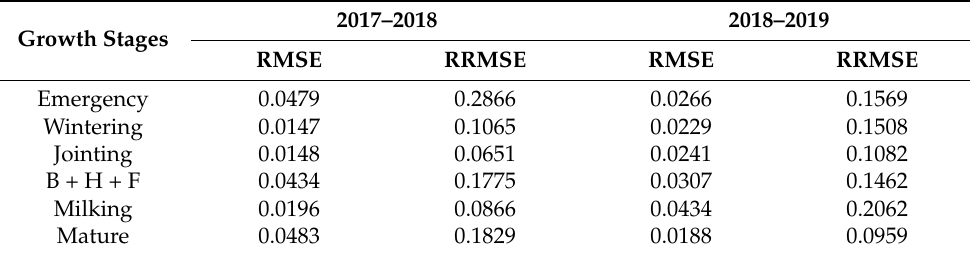
Figure 2. Measured and simulated values of soil water content during wheat growth stages in 2017–2019. Table 1. Simulation errors of soil water content during wheat growth stages in 2017–2019.